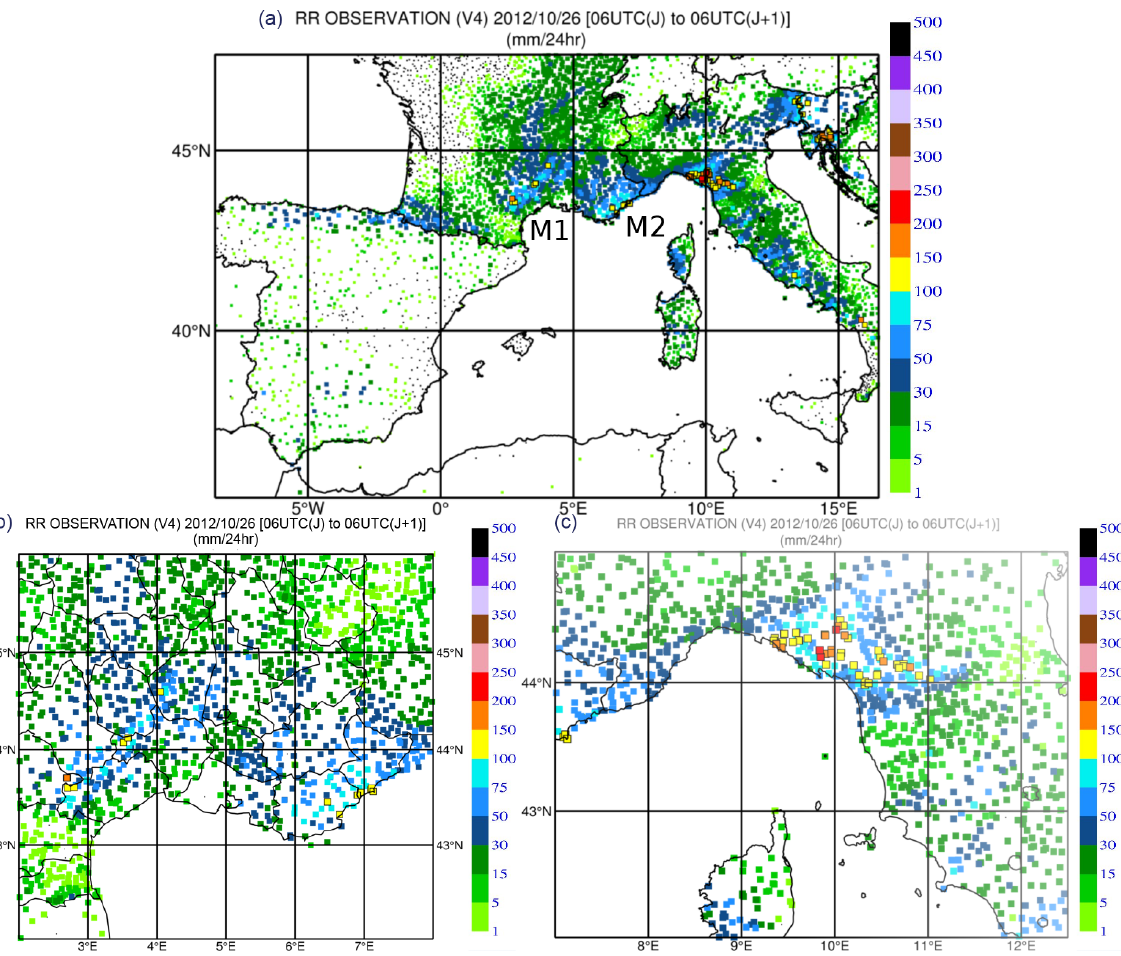
Figure 17. Accumulated precipitation (mm) for 24h between 26 October at 06:00UTC and 27 October 2012 at 06:00UTC over the AROME- WMED domain (a) and zoom over the Cevennes region (b) and over the north of Italy (c) . Please note that the dates given in the figure are in the format of year month day (yyyy/mm/dd). RR: rain